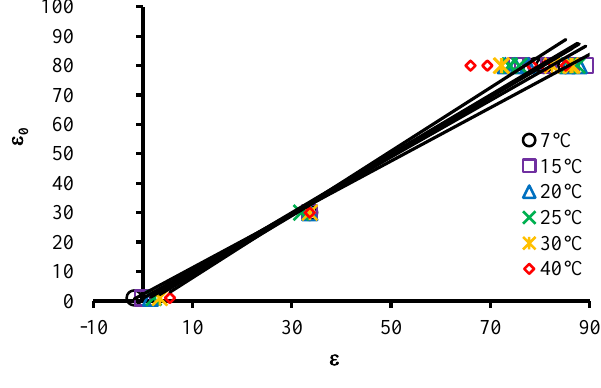
Figure 7. Models for comparison between measured values and true conventional values of ε for each different temperature.